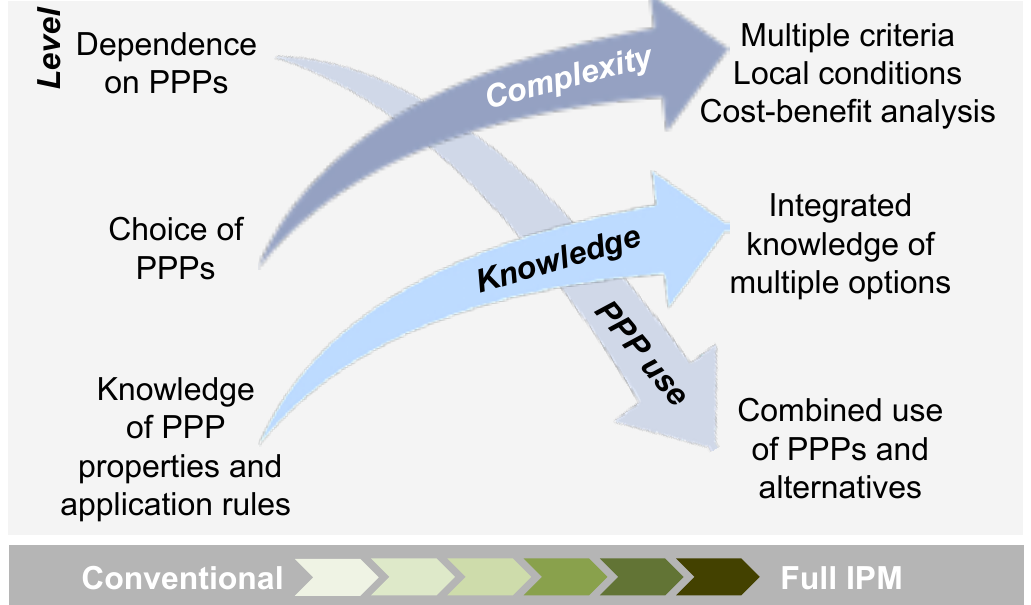
Figure 5. Implementation of IPM requires more knowledge and involves greater complexity than implementation of con - ventional agricultural